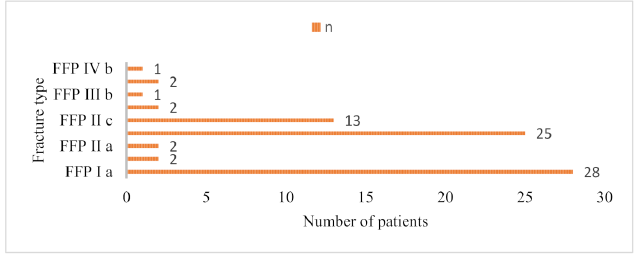
Figure 2. Distribution and numbers of FFP type.